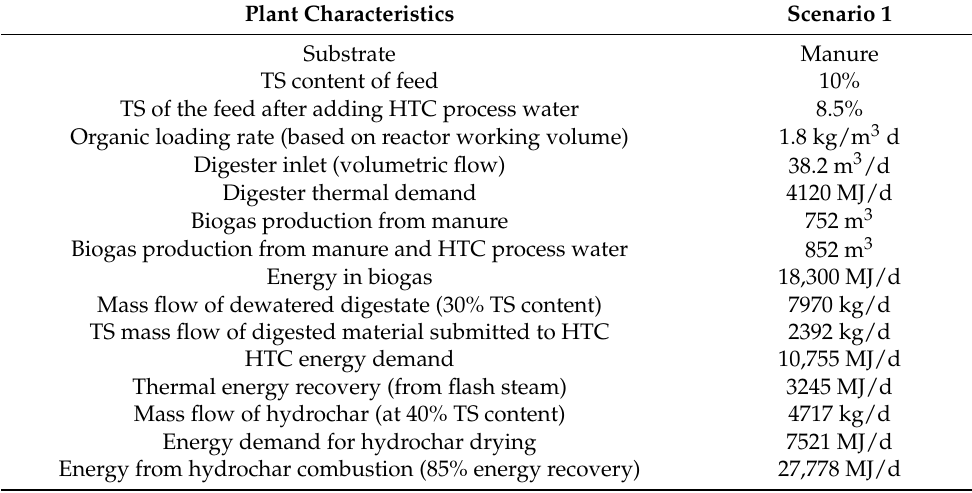
Table 2. Main calculated parameters of the integrated system: anaerobic digestion and